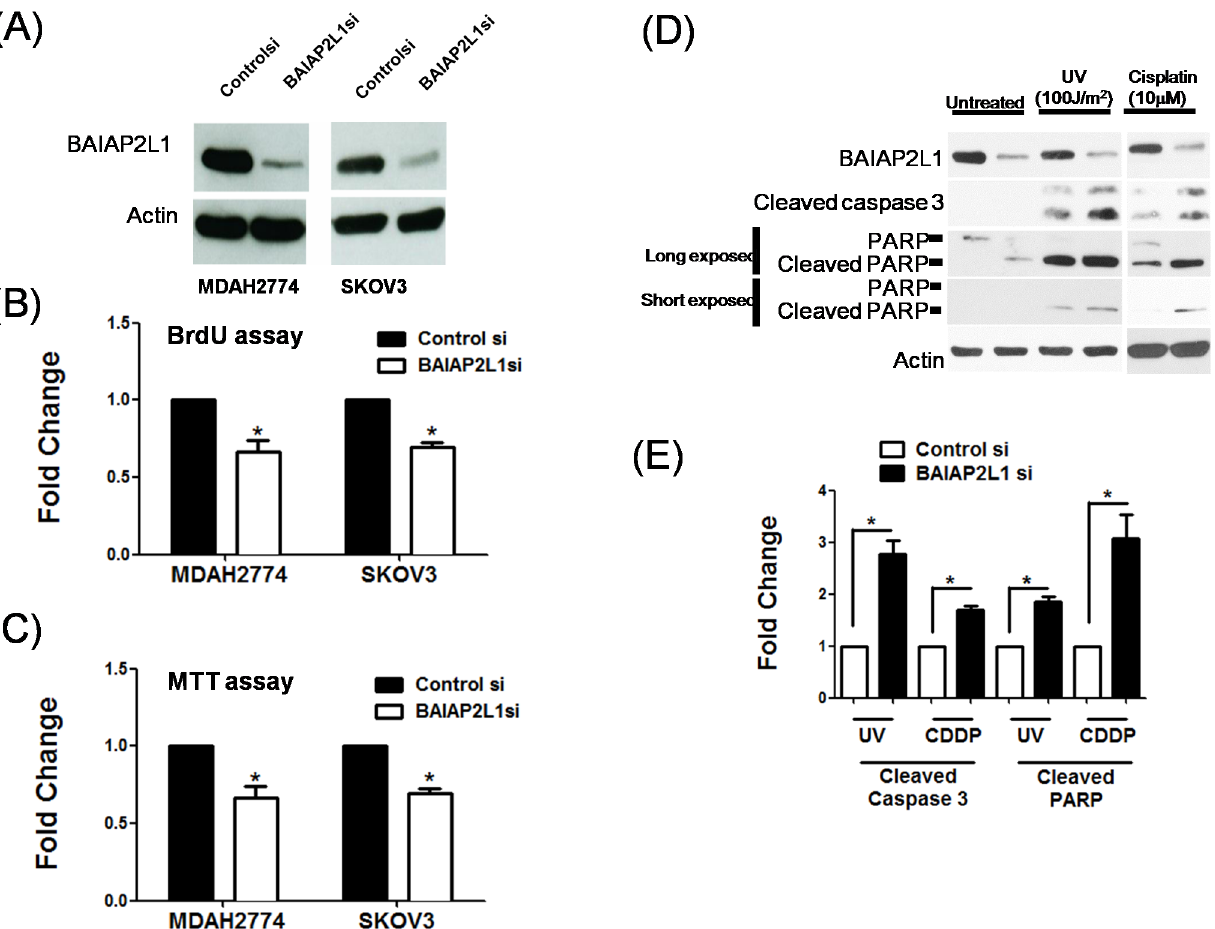
Fig 6. Knockdown of endogenous BAIAP2L1 inhibits cell proliferation and enhances apoptosis induced by UV and cisplatin. BAIAP2L1 in two ovarian cancer cell lines (MDAH2774 and SKOV3) were knockdowned with si-RNA (A) and analyzed with (B) BrdU incorportation assay and (C) MTT assay. (D) BAIAP2L1 knockdown in SKOV3 cells increased cleavage of caspase 3 and PARP, which were indicators of apoptosis. The cells were irradiated with UV (100 J/M 2 ) or treated with 10 μ M cisplatin for 24 h to induce apoptosis. To clearly visualize the differential intensities of cleaved PARP bands, two exposure times were used during chemiluminescence: long (60 sec) and short (10 sec). The actin level was used to normalize the amount of input protein. (E) Quantitative analyses of cleaved caspase 3 and PARP. Results shown are the mean ± standard error from three independent experiments. Asterisks denote statistical significance (p <